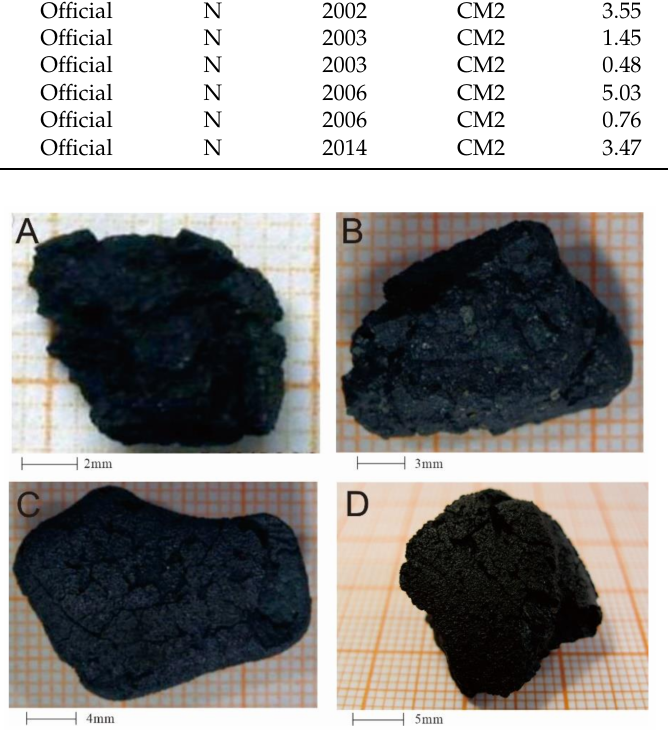
Figure 1. Typical specimens of CM chondrites in Grove Mountains, Antarctica: ( A ) GRV 020005; ( B ) GRV 020017; ( C ) GRV 020025; ( D ) GRV